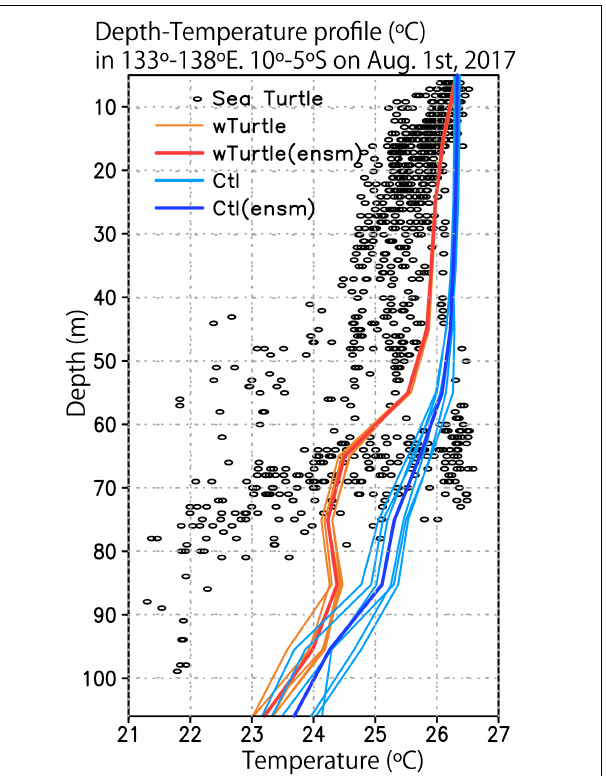
FIGURE 3 | (A) Difference in the ocean mixed layer depth (MLD) in August 2017 between the ensemble mean of wTurtle_forecast and that of Ctl_forecast (m). Black dots indicate the statistically significant difference in the ensemble means between them beyond the 90% confidence levels on paired t -test are shown by black dots. The region for Figure 4 is shown by a black box. (B) The same as (A) but for the sea surface temperature (SST) in November 2017 ( ◦ C). The region for Figure 6 is shown by a black box.